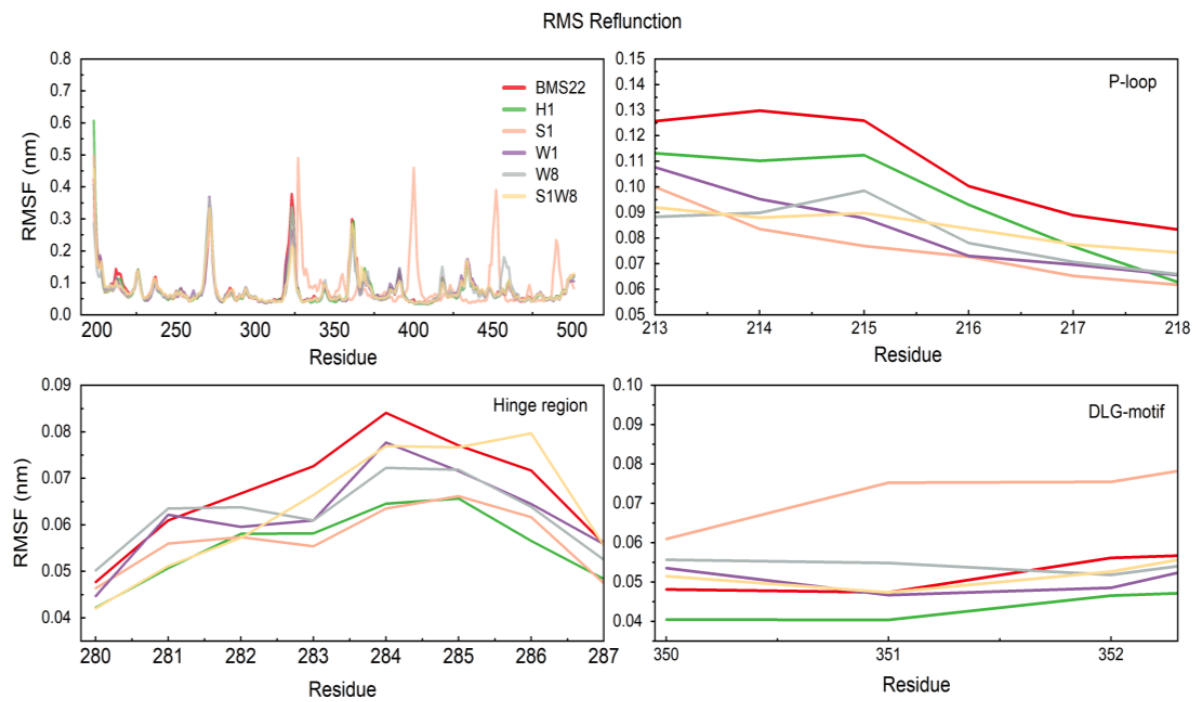
Figure 7. RMSF plot of the TGFβR Ⅰ residues in different systems during the 100ns MD simulations.